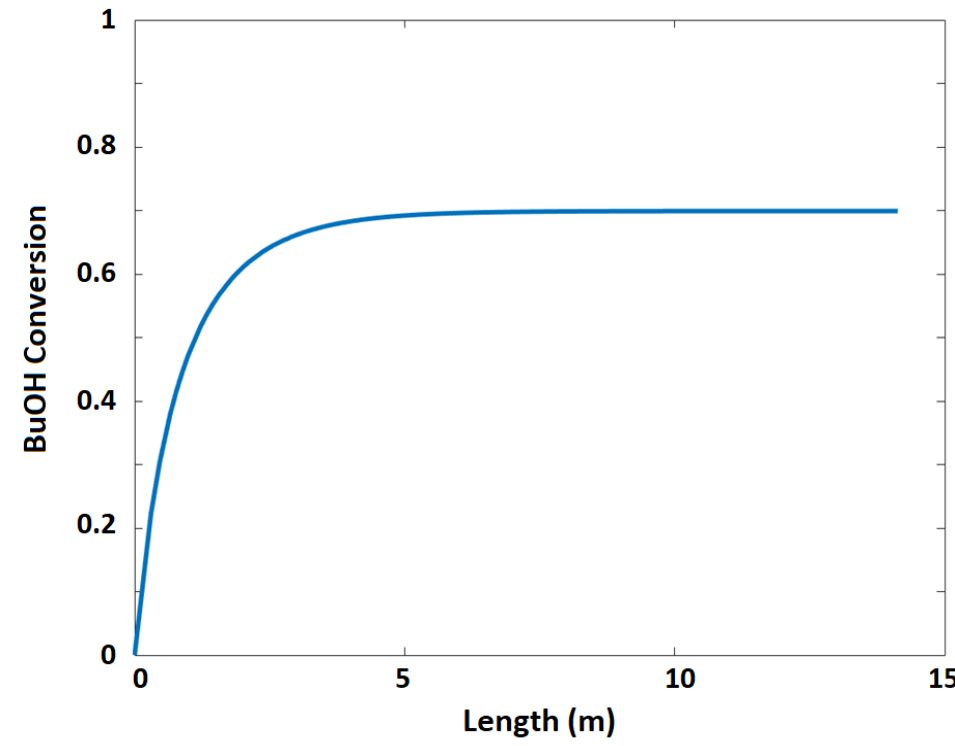
Figure 14. n -butanol conversion as a function of reactor length.